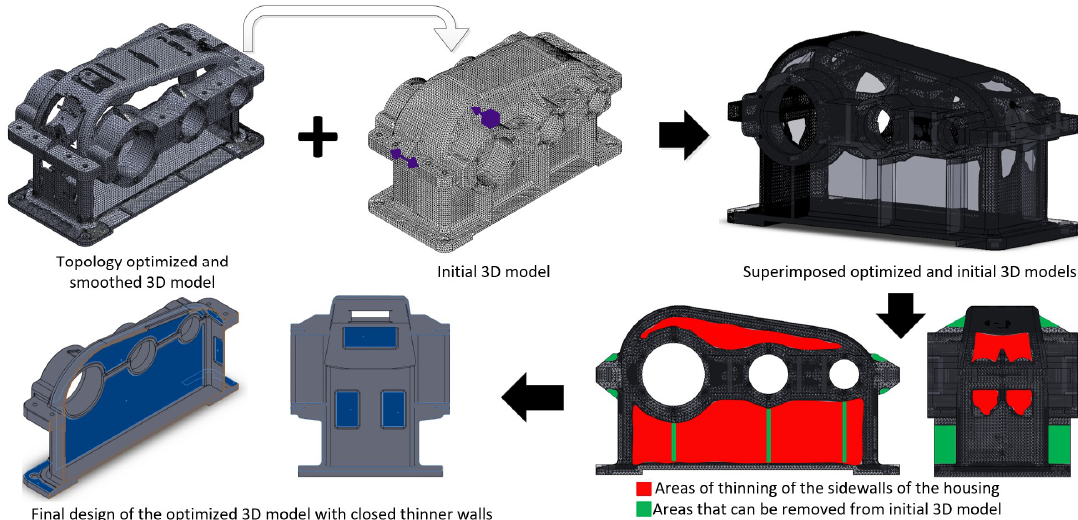
Figure 8. Postprocessing steps to obtain the final optimized 3D design of the gear reducer Figure 8. housing elements.